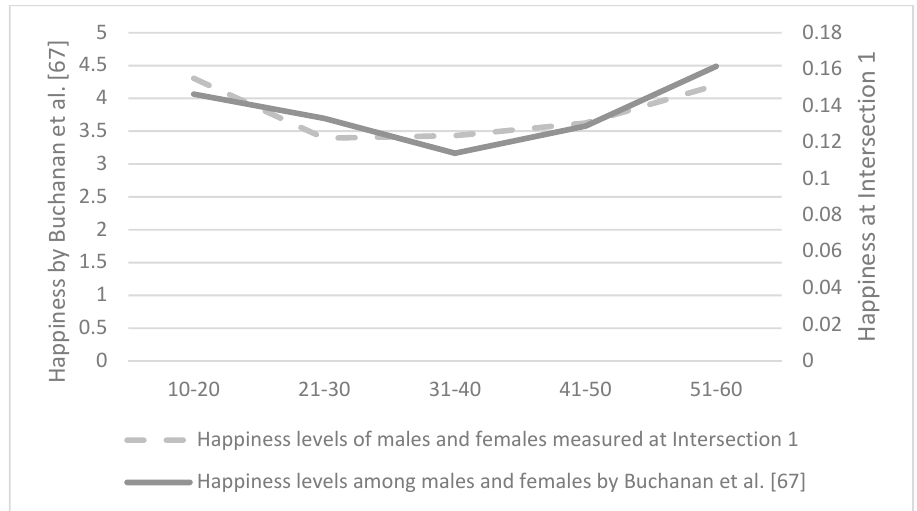
Figure 3. Correlation between the happiness levels among males and females measured at Intersection 1 and those by Buchanan et al. [67] (equals 0.84).